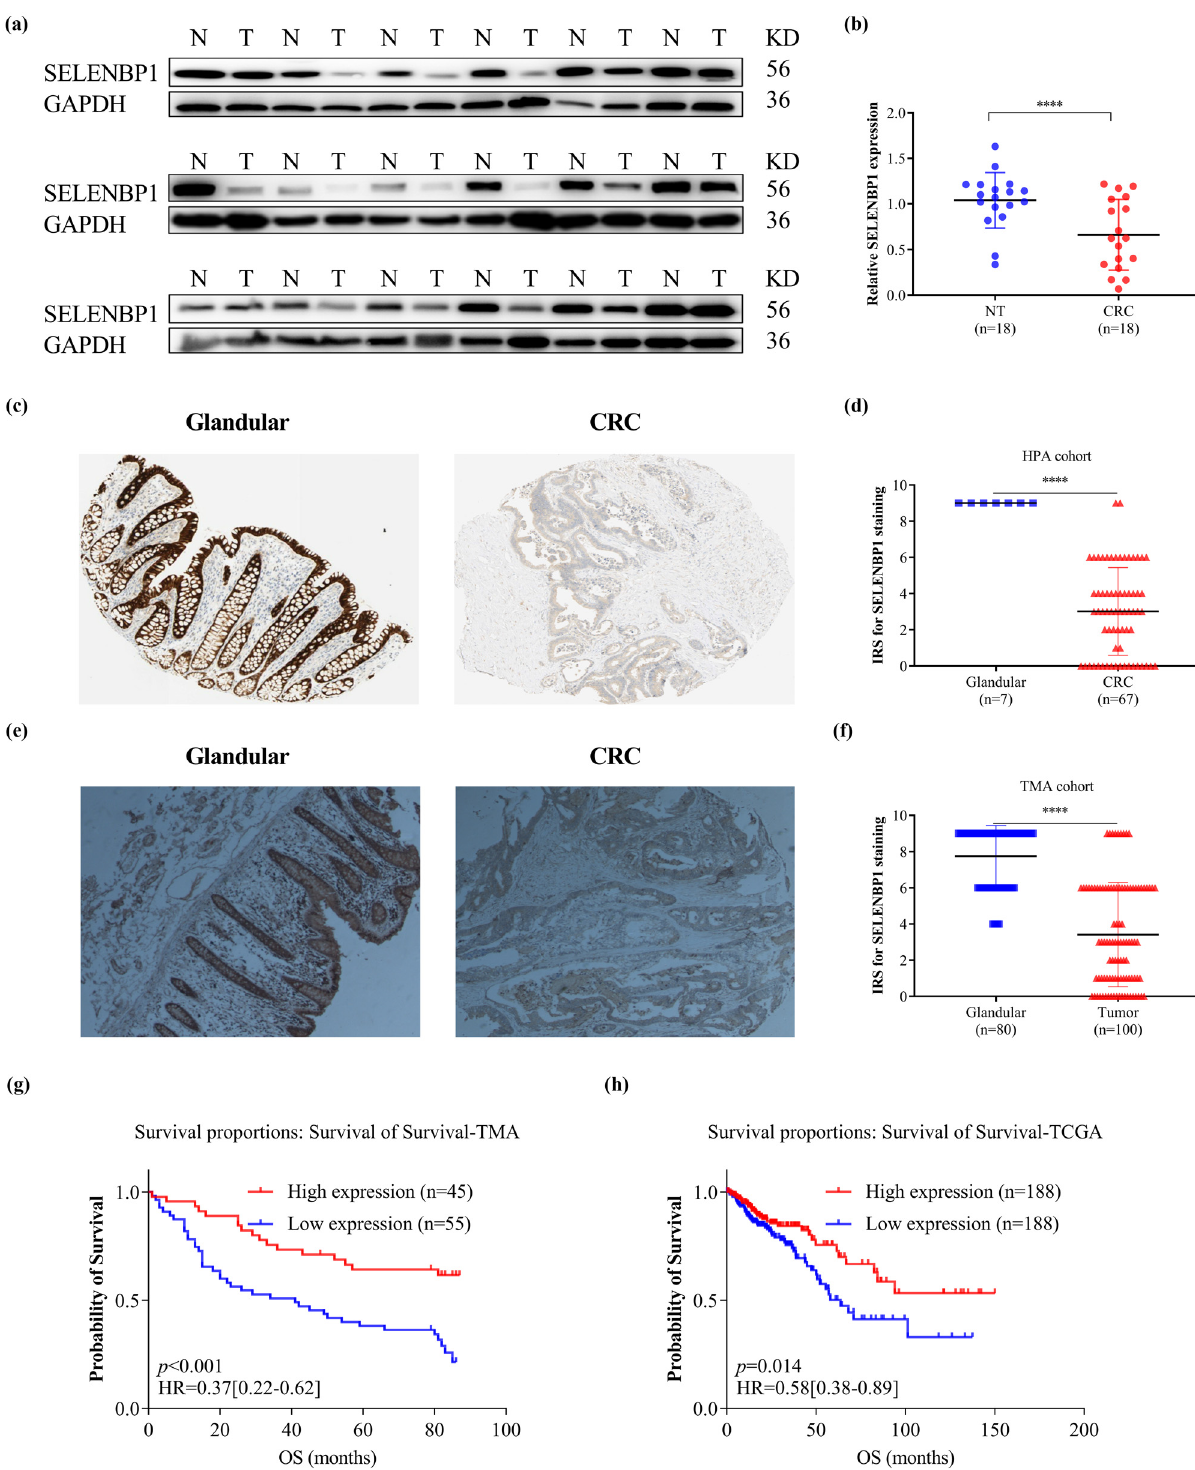
Figure 3: Suppressed expression of SELENBP1 in CRCs is associated with poor patient survival. The expression of SELENBP1 protein was detected by WB in 18 pairs of NTs and CRCs ( a ) and quanti fi ed by gray - scale analysis ( b ) . Immunohistochemistry data of SELENBP1 were downloaded from the HPA database and compared between glandular tissues and CRCs using an IRS method ( c and d ) . A TMA consisting of 100 CRCs and 80 NTs was stained with an anti - SELENBP1 antibody ( d, 40 ×) and the IRS was evaluated ( f ) . Kaplan – Meier plots were drawn for OS of patients in the TMA cohort ( g ) and TCGA cohort ( h ) . Patients were strati fi ed into low and high SELENBP1 expression groups according to SELENBP1 mRNA expression in the TCGA cohort and IRS of SELENBP1 in the TMA cohort (< median vs ≥ median ) . Values of p were obtained using the log - rank test. Censored data are indicated by the + symbol. *** p < 0.001; **** p < 0.0001 vs the control